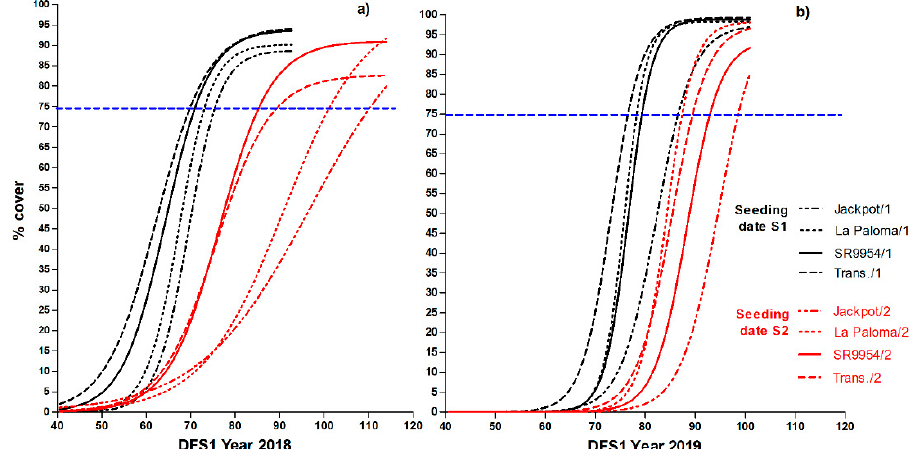
Figure 3. Turfgrass green cover of four bermudagrass cultivars in 2018 ( a ) and 2019 ( b ) as a function of the days from the first seeding time (DFS1). Graphs show the coverage predictions of sigmoidal models of both the first seeding time (S1) in black and the second seeding time (S2) in red. The blue dashed line shows the full establishment at 75% green